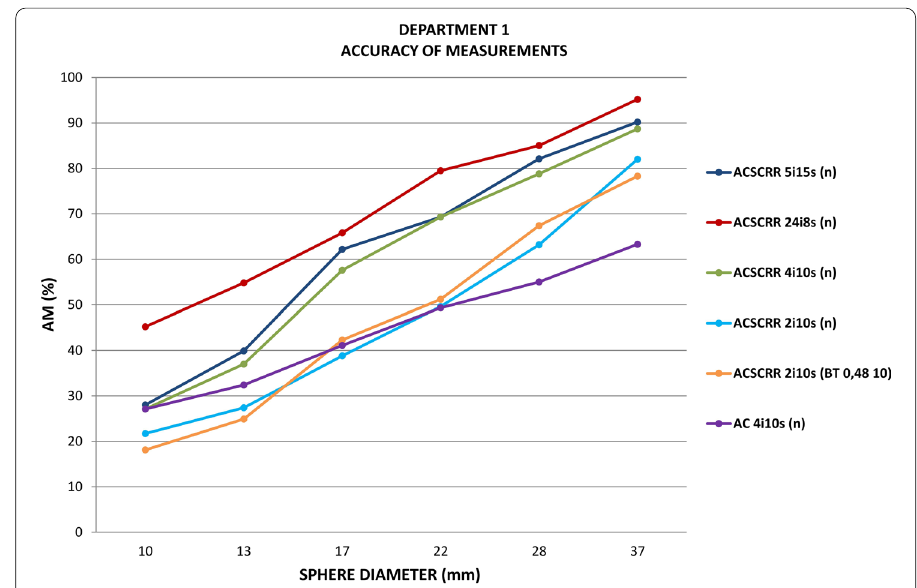
Fig. 4 Accuracy of measurements (AM) for activity in 6 spherical inserts of the NEMA/IEC Body Phantom scanned with Discovery NM/CT 670 gamma camera in Department